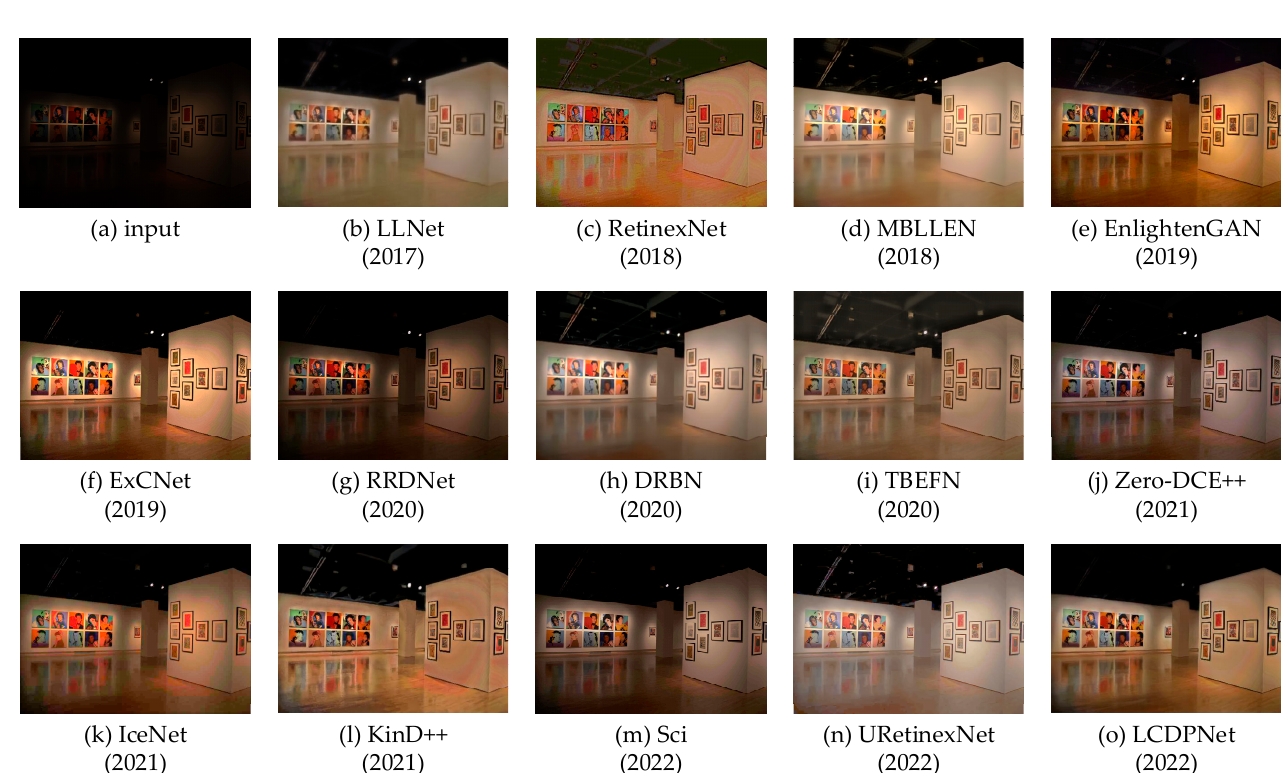
Figure 7. Visual results of different algorithms on low-illumination images sampled from the LIME dataset.